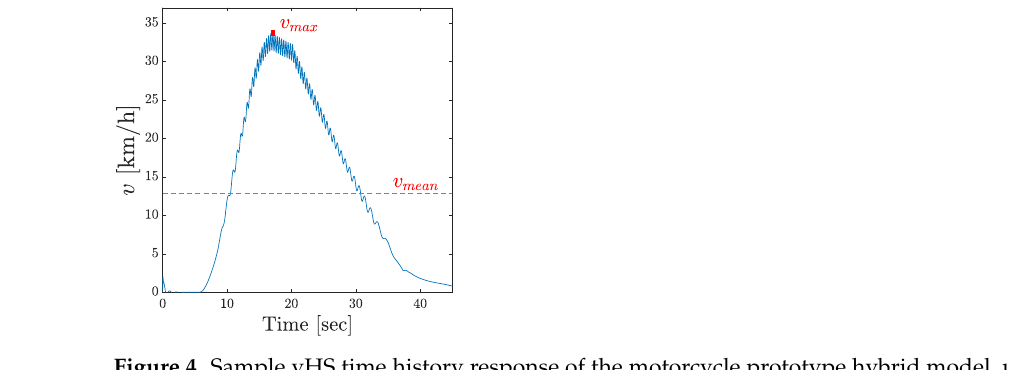
Figure 4. Sample vHS time history response of the motorcycle prototype hybrid model, using the mean (nominal) values of Table 1. The QoI are highlighted in red color.